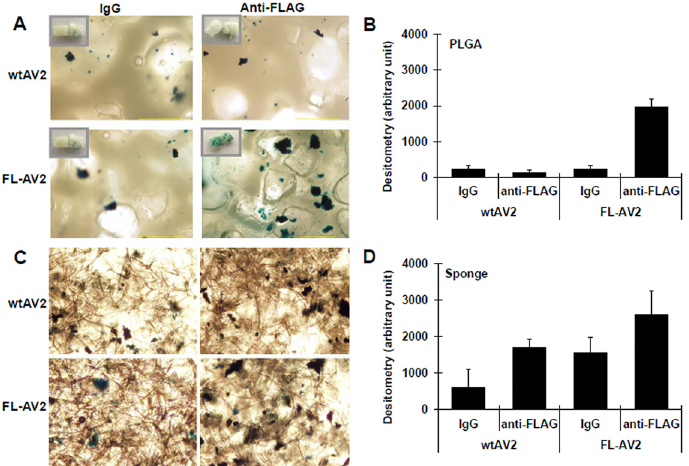
Fig 4. Transduction of immobilized FL-AV2 with FLAG antibodies in 3D cell cultures in vitro . Tissue engineering scaffolds of PLGA (A) and gelatin sponge (C) were pre-coated with bovine type I collagen. Anti- FLAG antibody or mixed IgG was cross-linked to the collagen coating. FL-AV2.LacZ was immobilized to the scaffolds overnight and clean washed with PBS. HeLa cells of 1×10 6 cells in 1 mL were seeded and cultured for 48 h prior to ß-gal staining was performed. The 10× phase-contract images were acquired under a Leica DMIRB microscope. Randomly selected 6 non-overlapped microscopic fields were analyzed for the area percentages of β -gal stained regions(B and D), and the values were used as a semi-quantitative indication of viral transduction